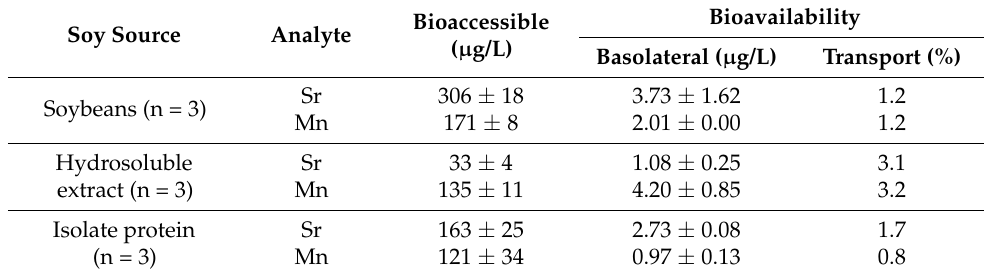
Table 4. Sr and Mn bioavailability using Caco-2